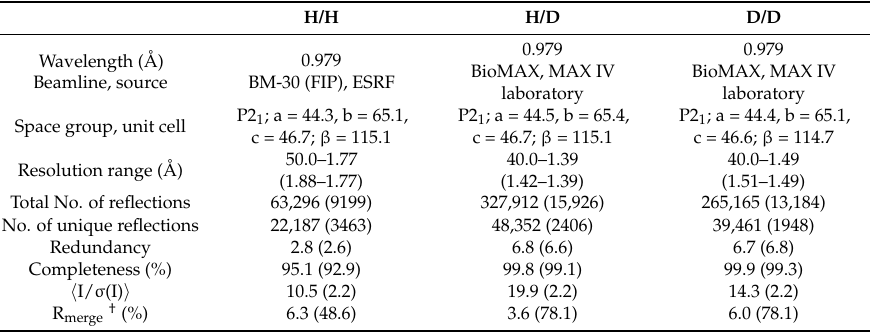
Table 2. X-ray diffraction data set statistics for CA IX